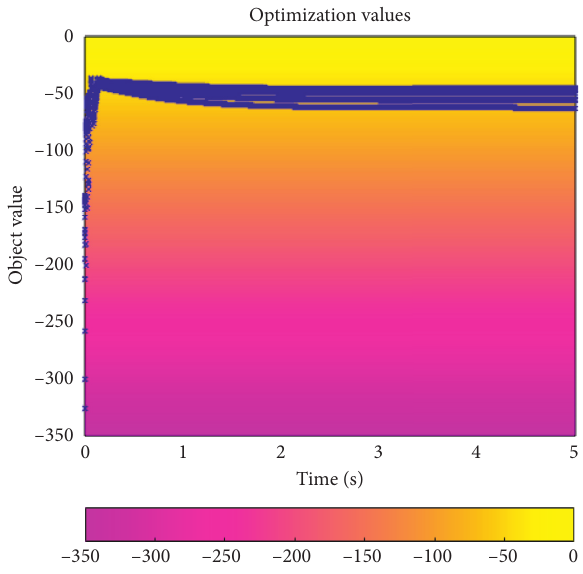
Figure 8: The cost function values of each